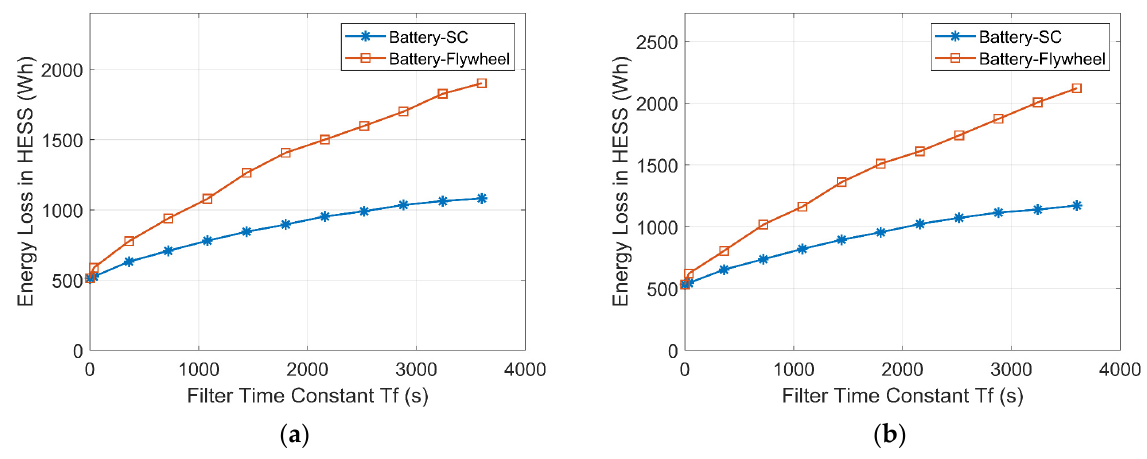
Figure 17. Variations of the energy losses of the HESSs with increasing T f . ( a ) Wind-powered household-prosumer system. ( b ) PV-powered household-prosumer system.